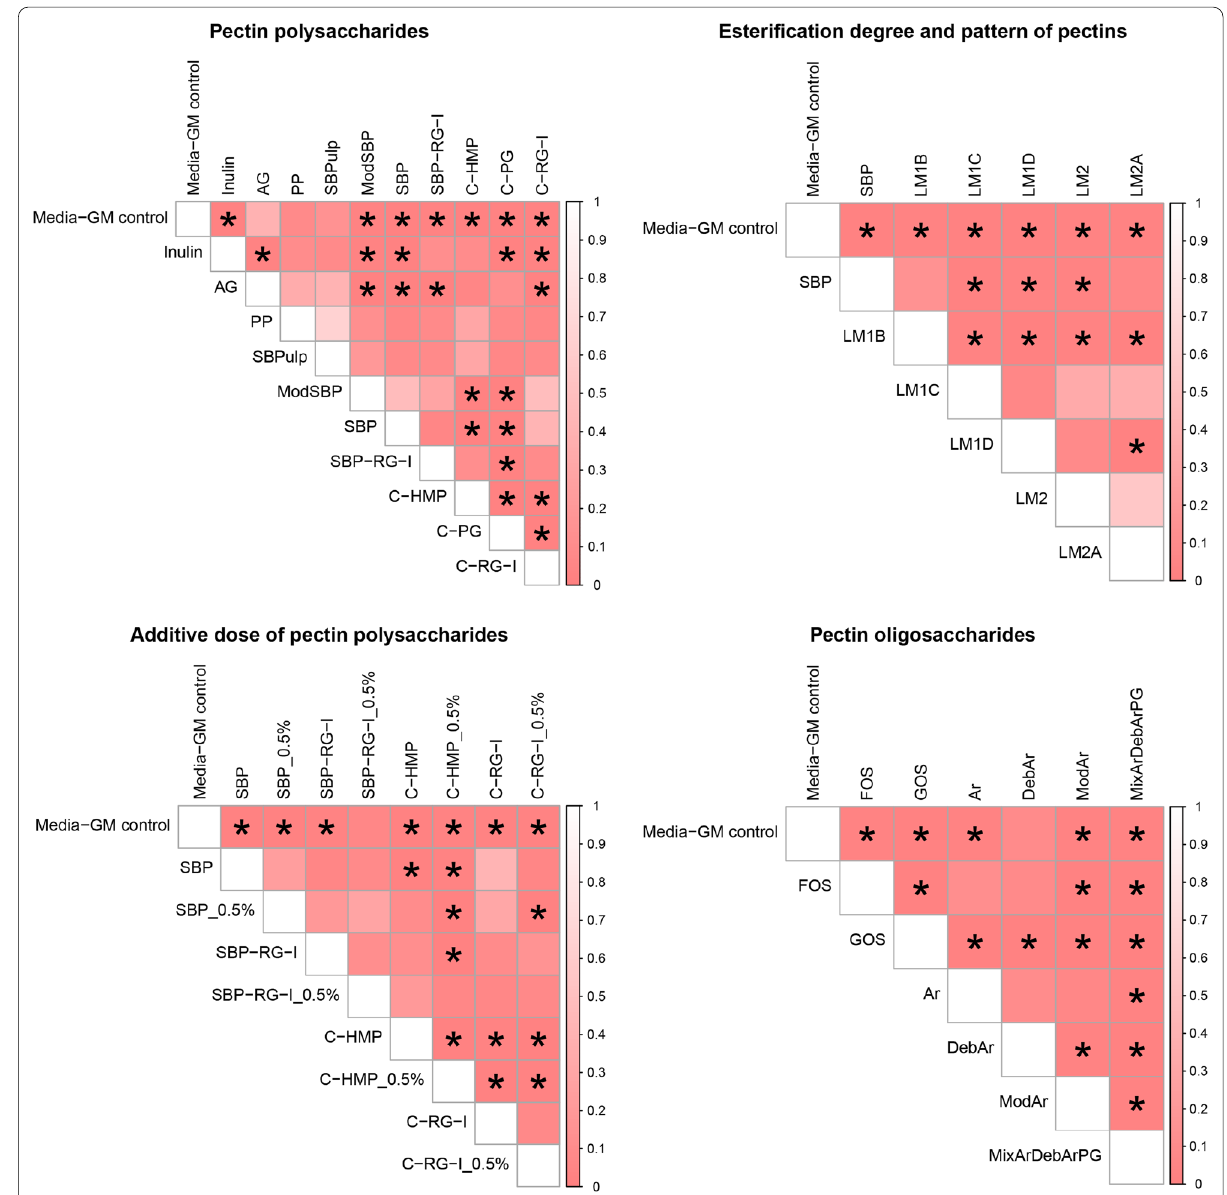
Fig. 4 Pairwise PERMANOVA tests on weighted Unifrac distance metrics visualized as heatmaps. Substrates were grouped to allow targeted comparisons: Polysaccharides sourced from pectins with inulin and AG (arabinogalactan) as prebiotic controls ( a ). Sugar beet pectins with different degrees and patterns of esterification ( b ). Different pectin polysaccharides at additive dose of 1% and 0.5% ( c ). Oligossaccharides derived from pectins with FOS (fructooligosaccharides) and GOS (galactooligosaccharides) as prebiotic controls ( d ). *P < 0.05. All fermentations were carried out in quadruplicate (with exceptions as stated in Fig.